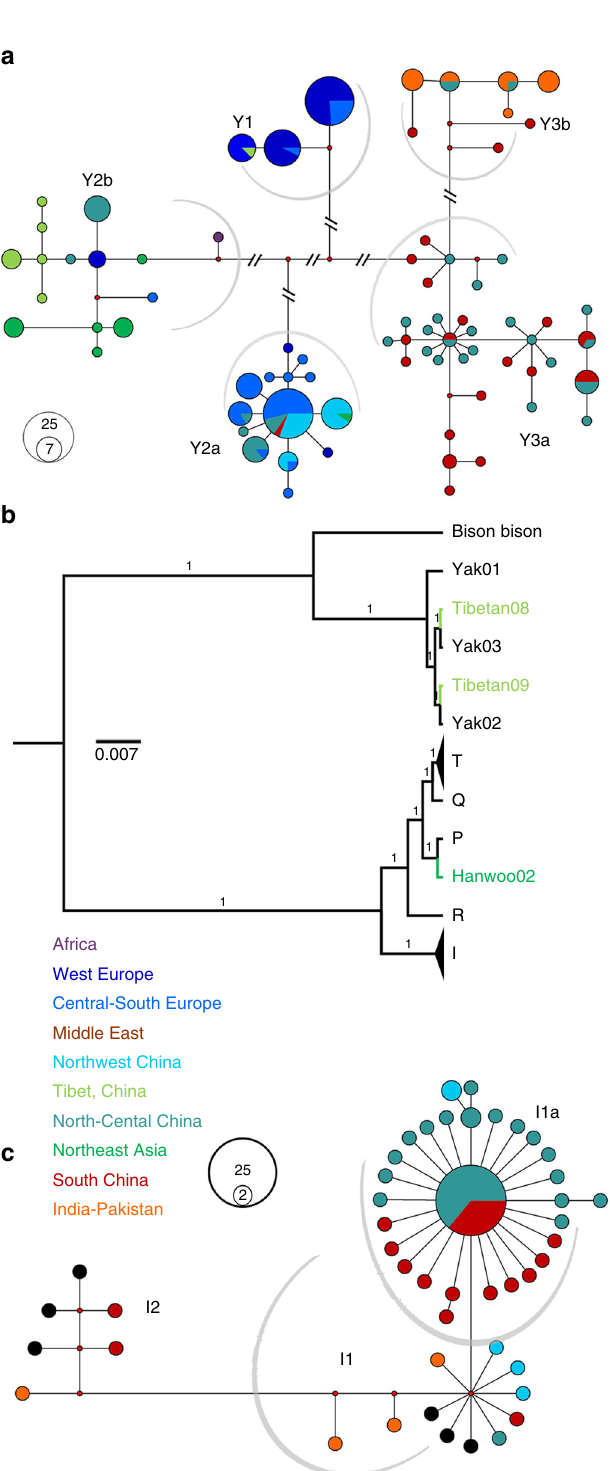
Fig. 3 Y-chromosome haplogroup and phylogeny of complete mitogenomes from modern cattle. a Median-joining (MJ) network of Y-chromosome haplotypes using 745 SNPs. b Rooted maximum-likelihood phylogenetic tree detailing the relationships among all available bovine haplogroups of I, P, Q, R and T mitogenomes, an American bison mitogenome and three yak mitogenomes. c MJ network of mitogenomes from Bos indicus . The black line and circle in b and c represent published reference sequences,